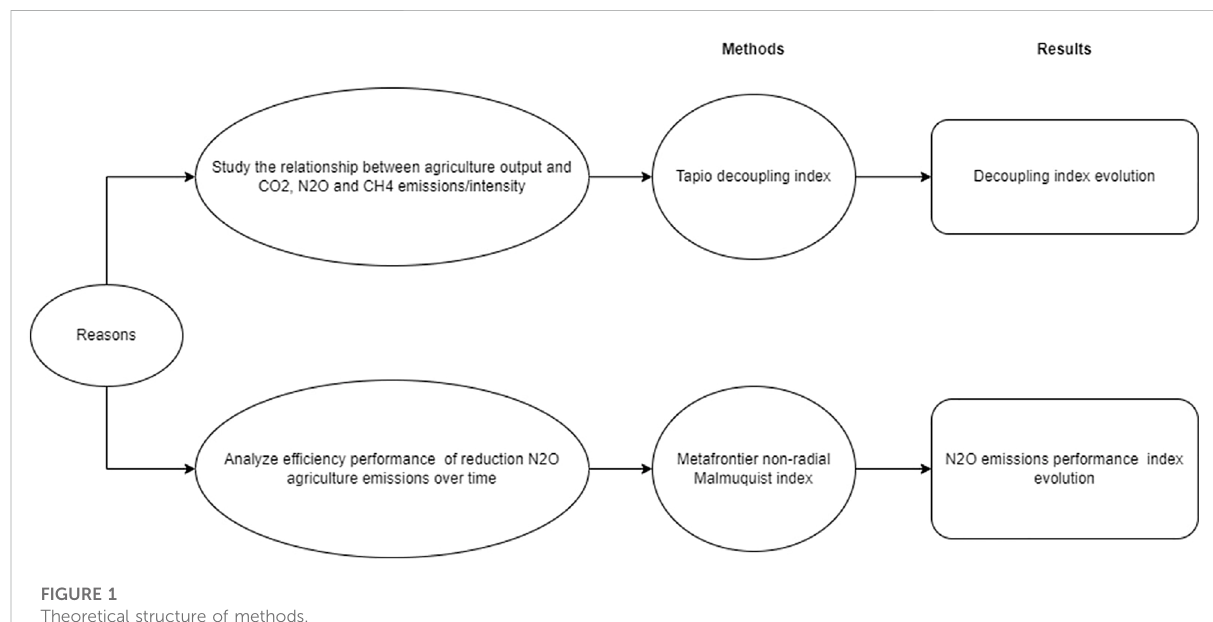
FIGURE 1 Theoretical structure of